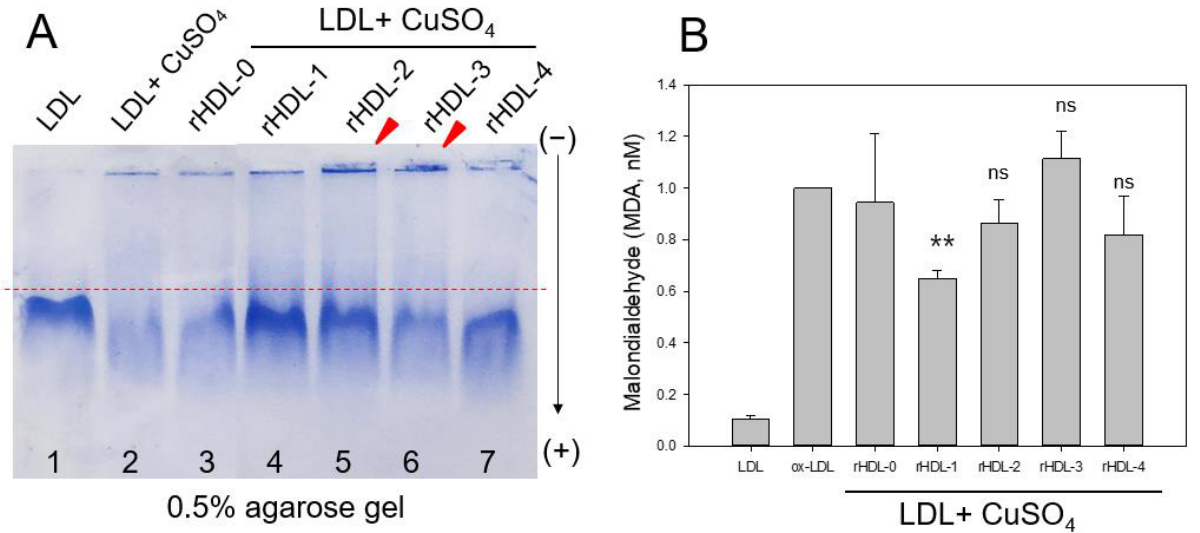
Figure 4. Comparison of the antioxidant abilities of rHDL-containing policosanol during cupric-ion- mediated LDL oxidation. ( A ) Comparison of relative electromobility of a mixture of LDL (8 μg of protein) and each rHDL (0.5 μg of protein) under a non-natured state on 0.5% agarose gel (120 mm length × 60 mm width × 5 mm thickness). The electrophoresis was carried out with 50 V for 1 h in Tris-acetate-ethylene-diamine-tetraacetic acid (EDTA) buffer (pH 8.0). The apo-B in LDL was visu- alized by Coomassie brilliant blue staining (final 1.25%). ( B ) Determination of oxidation extent by TBARS assay with the malondialdehyde (MDA) standard. Each rHDL treatment was compared with LDL + CuSO 4 (oxLDL) by paired t -test. Data were expressed as mean ± SD from three inde- pendent experiments with duplicate samples. **, p < 0.01 versus oxLDL alone; ns, not significant versus oxLDL alone.